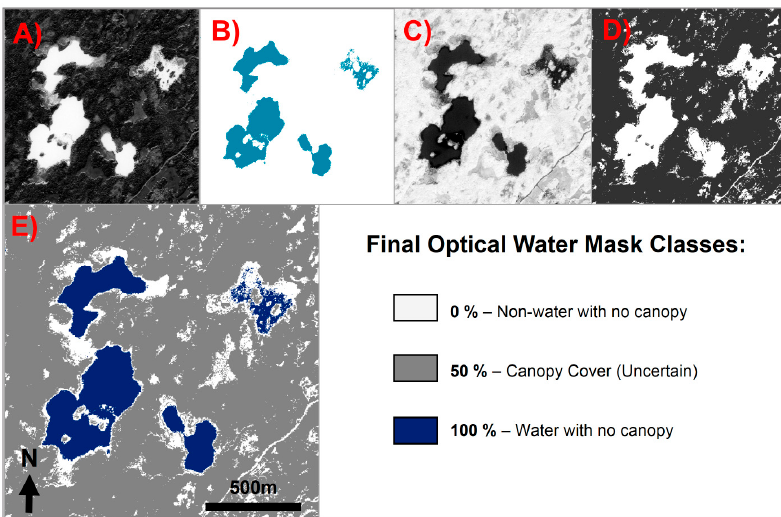
Figure 8. Masks created using 8-band multispectral WorldView-2 imagery from 26 August 2016: ( A ) NDWI (Low values are in black, high values are in white); ( B ) Optical water mask showing two classes; water (blue), non-water (white); ( C ) NDVI (Low values are in black, high values are in white); ( D ) Error mask showing two classes; error/canopy zones in black, and no error in white; and ( E ) Final optical water mask showing three classes representing the probability that a pixel is water.